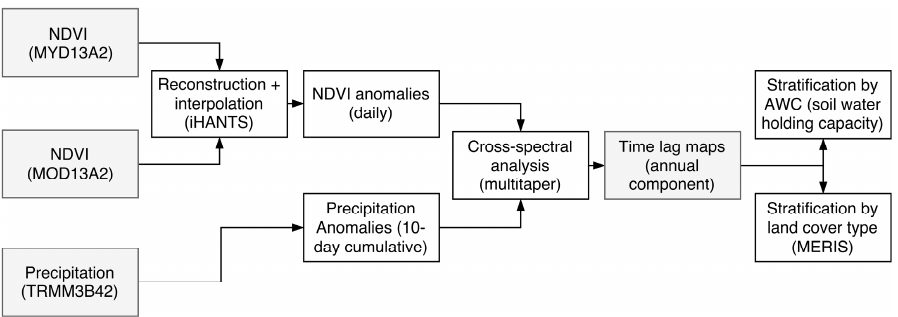
Figure 5. Flowchart representing the steps composing the methodology of data processing.